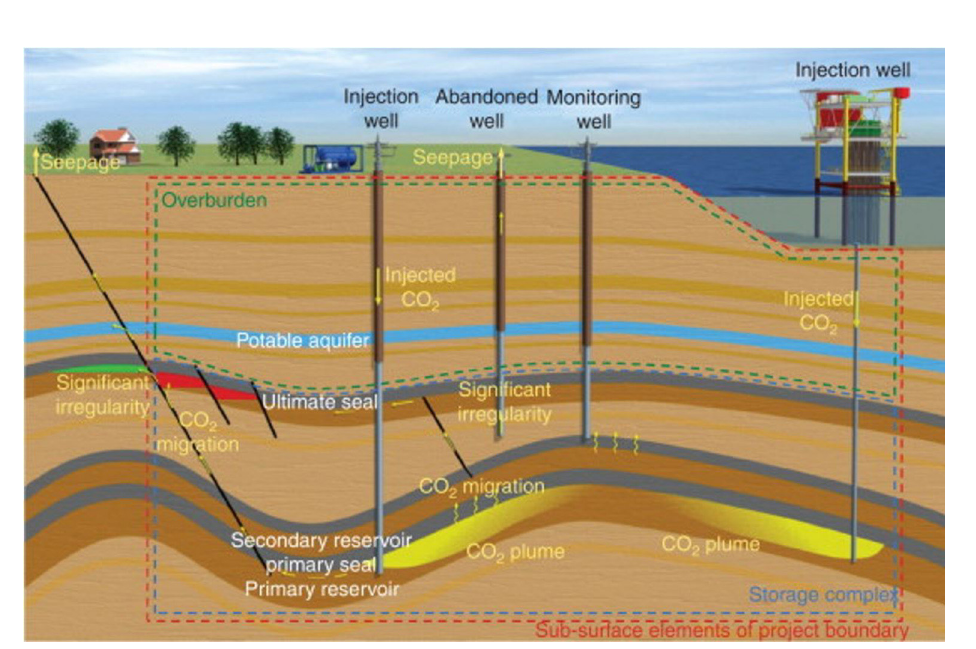
Fig. 15. – Conceptual cross-section of the CO 2 storage site/complex definitions. Highlighted in green, the outline of the “overburden” is also shown